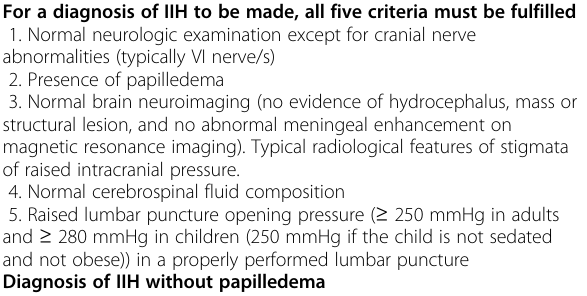
Table 1 Criteria to diagnose IIH For a diagnosis of IIH to be made, all five criteria must be fulfilled 1. Normal neurologic examination except for cranial nerve abnormalities (typically VI nerve/s) 2. Presence of papilledema 3. Normal brain neuroimaging (no evidence of hydrocephalus, mass or structural lesion, and no abnormal meningeal enhancement on magnetic resonance imaging). Typical radiological features of stigmata of raised intracranial